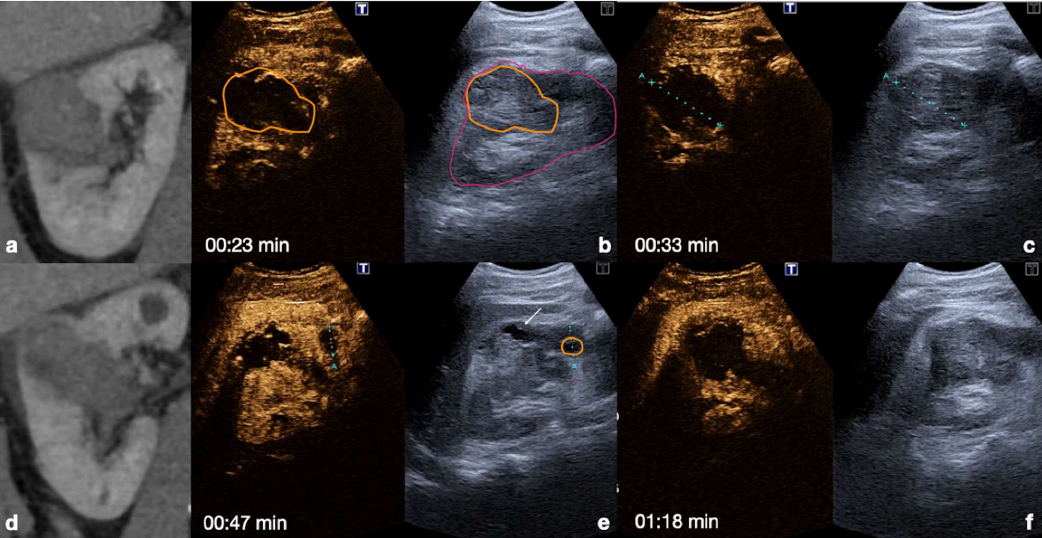
Figure 10. CT ( a , d ) and follow-up CEUS ( b , c , e , f ) of the right kidney in a 57−year-old patient who fell from a height. Follow-up CEUS was performed four days after the admission CT. Note at CEUS the progressive enhancement, at different time points, of the renal cortex in about 30 s ( b , c ) and the medulla, up to 2.5 min ( e , f ) . The parenchymal hematomas appear as non-enhancing collections ( b , e , orange lines) contained in the organ capsule ( b , pink lines), without internal enhancing vessel or associated vascular injuries. Due to the physiological evolution of the hematoma, the follow-up, it shows small fluid anechoic areas related to the progressive resorption ( e , arrow). Figure 10 is re- printed with permission from Iacobellis F., Acampora C., Ponticiello C., Stavolo C., Scuderi M.G., Cinque T., Pinto A., Gagliardi N., Romano L. Technique and advantages of contrast-enhanced ul- trasound versus MDCT in the follow-up of solid organ injuries. Electronic Presentation Online Sys- tem (EPOSTM) Educational Exhibit ECR 2018 Iacobellis et al., doi: 10.1594/ecr2018/C-2010. ref. [30], 2021, Iacobellis, F.; et al.